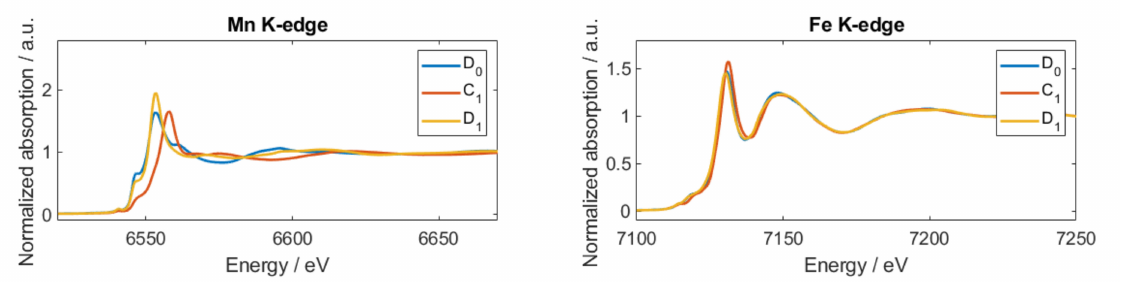
Figure 2. Spectra at the Mn and Fe K-edges for D 0 , C 1 , and D 1 states of